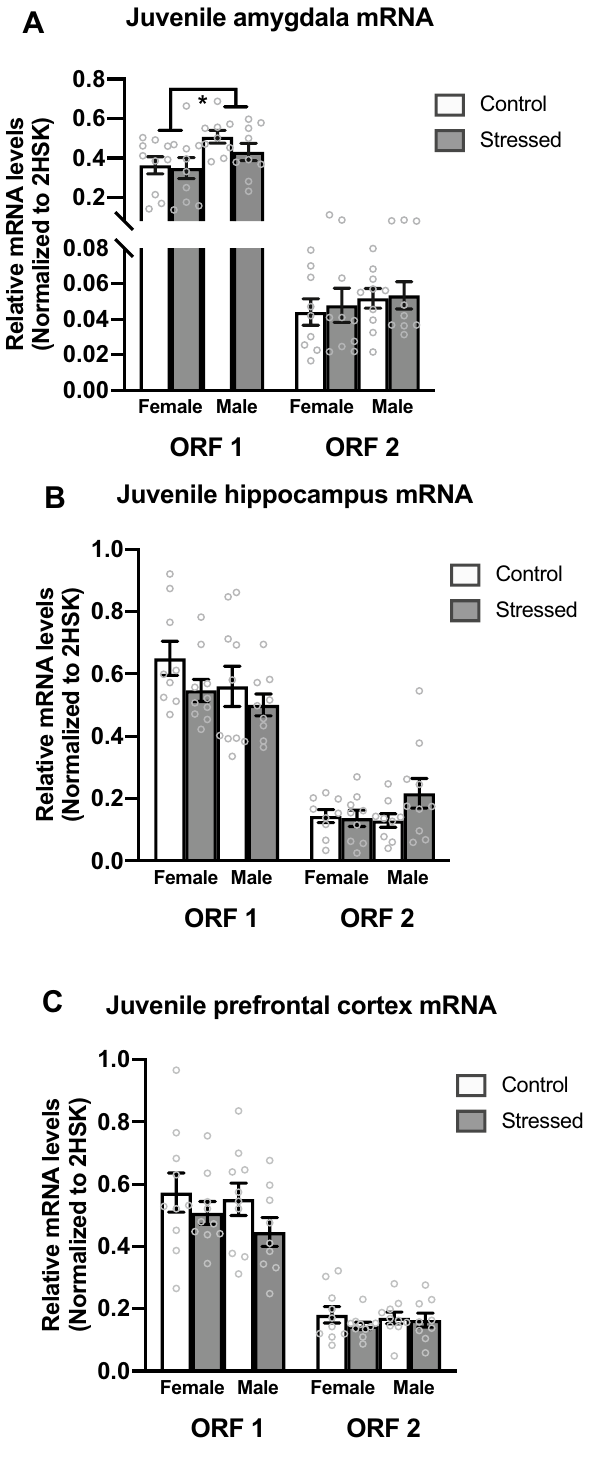
Figure 3. RT-qPCR analysis of Line1 Orf1 and Orf2 mRNA in the juvenile amygdala, hippocampus, and prefrontal cortex. ( A ) Males have greater Line1 mRNA expression than females in the juvenile amygdala. ( B ) No changes in Line1 mRNA expression were observed in the juvenile hippocampus. ( C ) No changes in Line1 mRNA expression were observed in the juvenile prefrontal cortex. Values shown as mean ± SEM. *Indicates p <